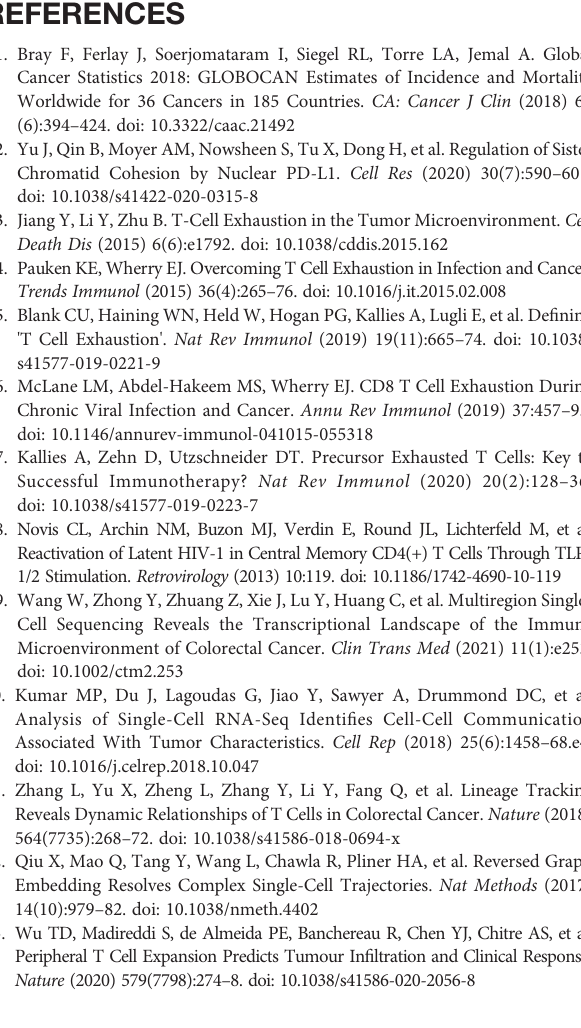
Supplementary Figure 1 | Genes expression of differentiation pro fi les in CD8 + T cells. (A) t-SNE clustering of CD8+ T cells in tumor tissue (n=1646) from scRNA- seq of CRC patients showing 8 clusters (n=8). (B) Violin plot indicating the expression distribution of HAVCR2, CXCL13, PDCD1, FOS, SELL and LAYN in NTC, PTC and TTC. (C) The expression levels of CCT6A, SRSF1, EIF4A3 and IFI44L in different pseudotime of CD8 + T cell subpopulation. The x-axis represents pseudotime, and the y-axis represents gene expression. (D) Five heatmaps